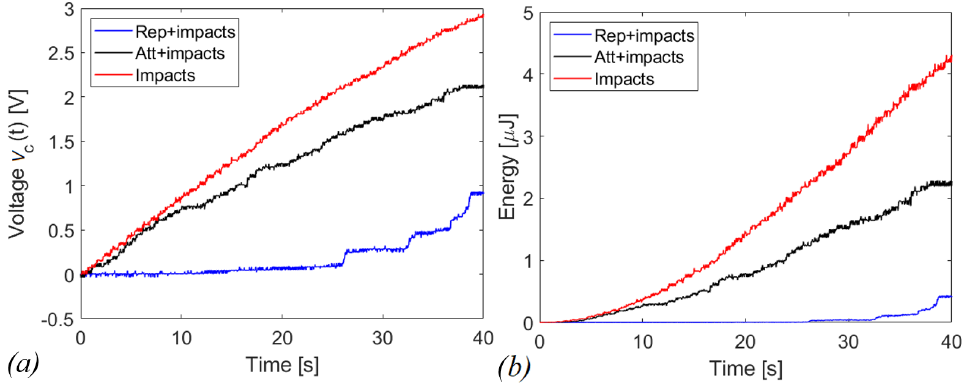
Figure 17. ( a ) voltage and ( b ) energy harvested in case of running with capacitive circuit (C 1 = 1 μ F).